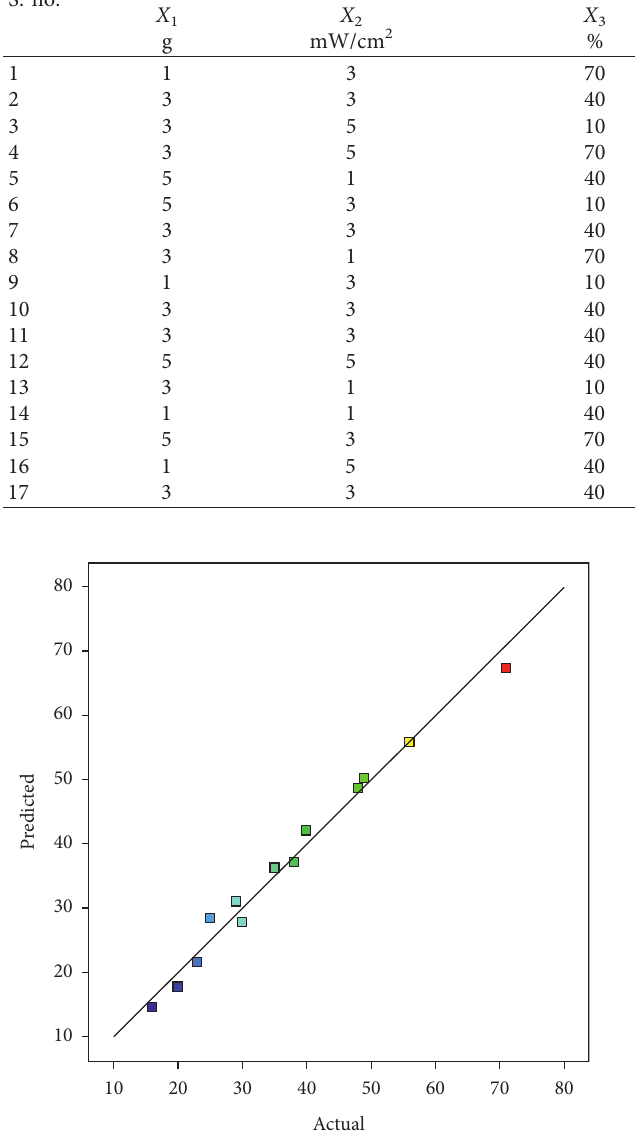
Figure 4: Predicted versus actual plots for degradation of NO